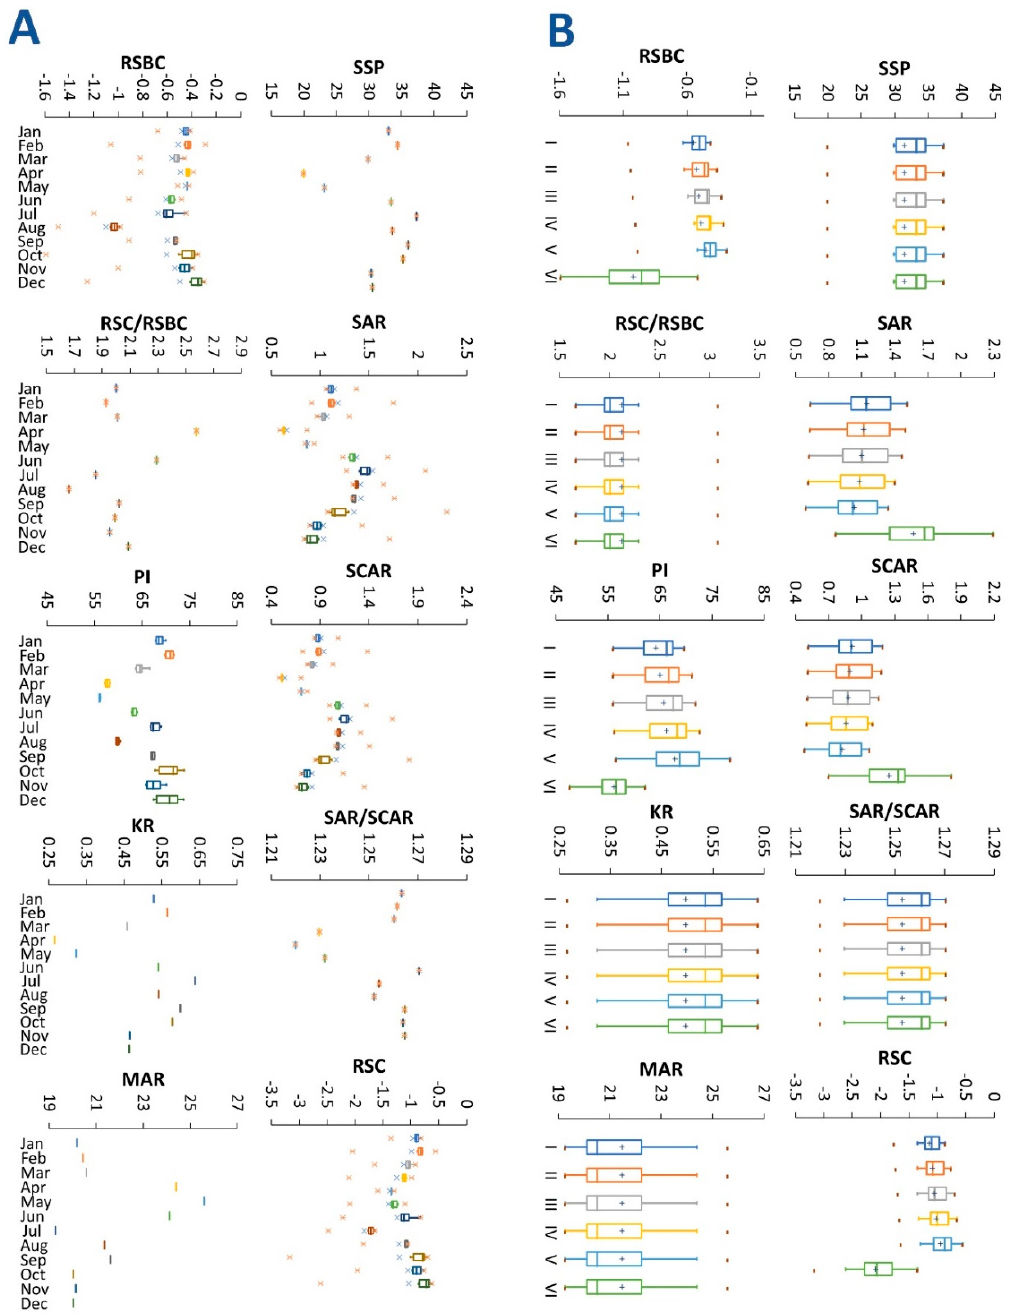
Figure 6. Spatiotemporal assessment of the Bahr Mouise canal water using traditional criteria—monthly ( A ) and spatially in each sampling site ( B ). RSBC: residual sodium bicarbonate; SSP: soluble sodium percentage; SAR: sodium absorption ratio; PI: permeability index; SCAR: sodium-to-calcium activity ratio; KR: Kelly ratio; MAR: magnesium absorption ratio; and RSC: residual sodium carbonate. Magnesium ratio: The magnesium hazard of irrigation water is evaluated using the MAR